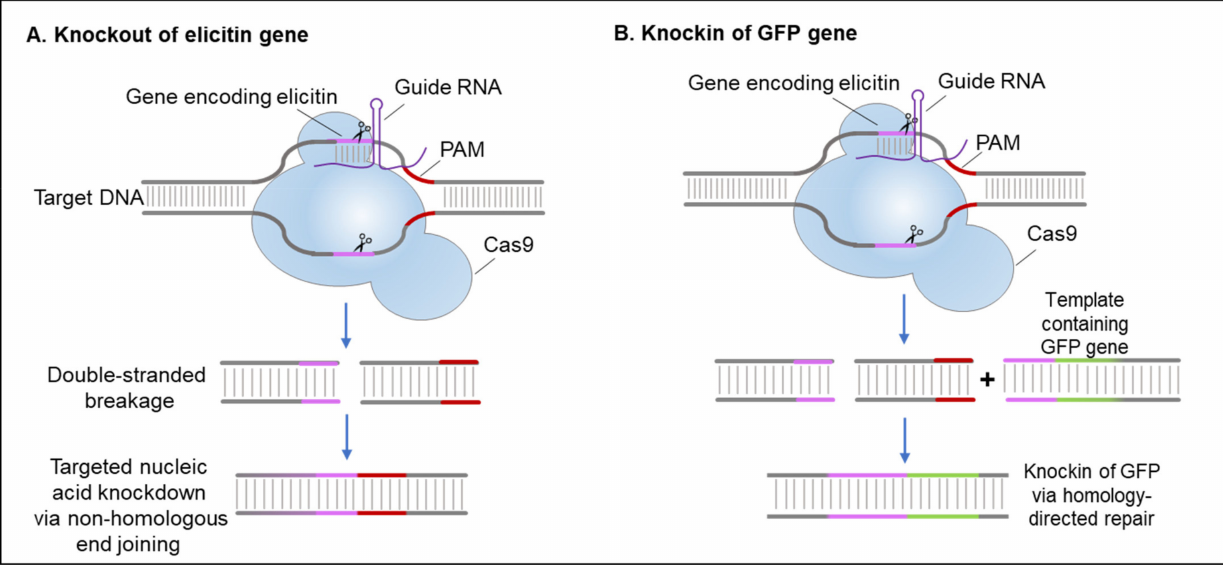
Figure 5. Concept of using site-specific CRISPR/Cas9-mediated gene editing to understand the functions of elicitins. ( A ) The generation of elicitin gene mutants with targeted nucleic acid knockdown to monitor the differences in infectivity of the pathogen. Knockout of the whole elicitin gene may lead to the inability of the pathogen to acquire sterols. ( B ) Knockin of the green fluorescent protein (GFP) (or similar markers) at the elicitin gene locus through homologous recombination to produce labeled elicitin proteins for detailed subcellular visualization and monitoring. Pink: elicitin gene, red: protospacer adjacent motif (PAM), purple: guide RNA and green: gene for the fluorescent